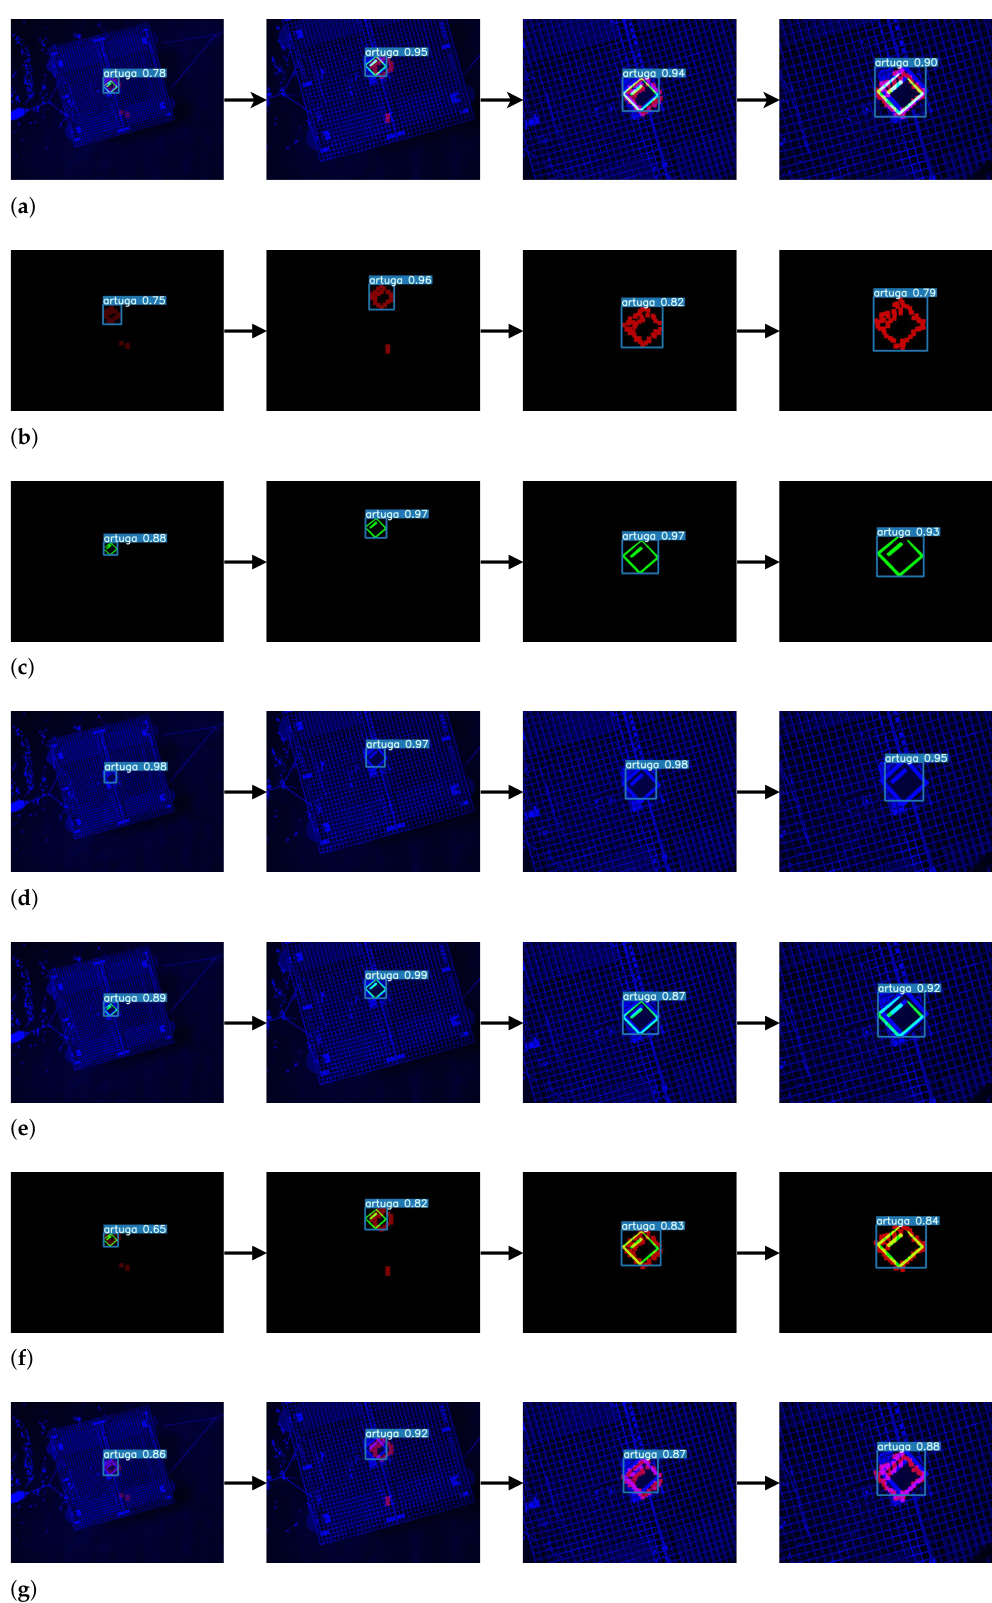
Figure 14. Examples of ablation test predictions for all sensor failure cases. ( a ) Early-fusion (baseline). All sources are activated. ( b ) Relying on LiDAR source only. ( c ) Relying on thermal source only. ( d ) Relying on visual source only. ( e ) LiDAR source failure. ( f ) Visual source failure. ( g ) Thermal source